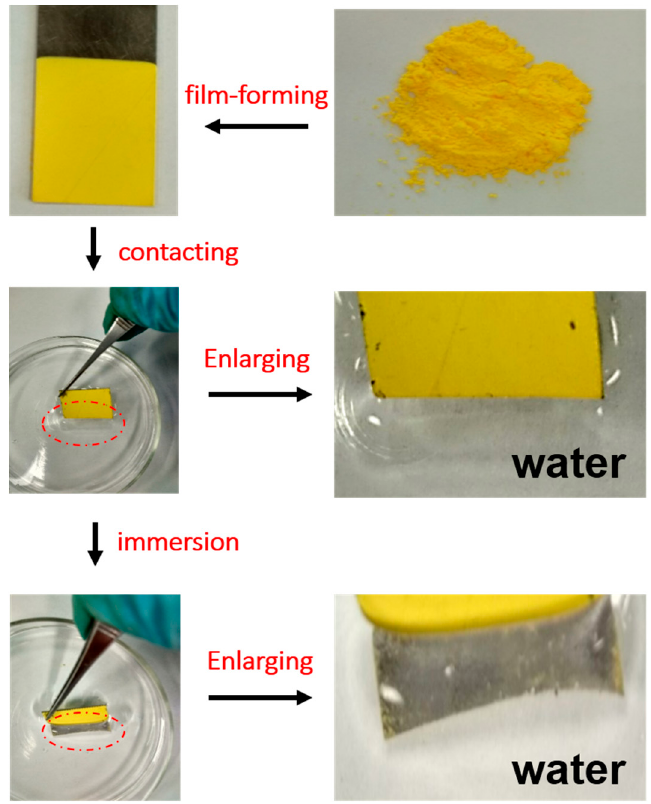
Figure 4. The film-forming process from nano-particles and the contacting and immersion process of the target hydrophobic nano-Bi 2 O 3 films, with the corresponding enlarged “red circle” parts.